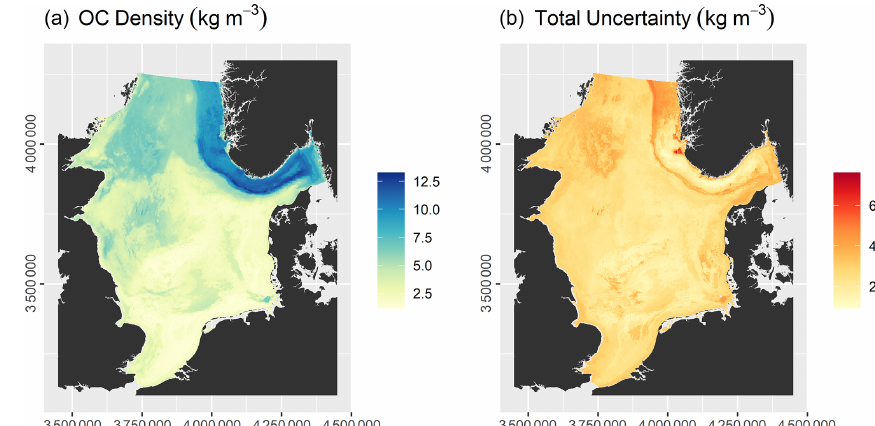
Figure 5. Predicted OC density (a) and associated uncertainty in the predictions (b) .